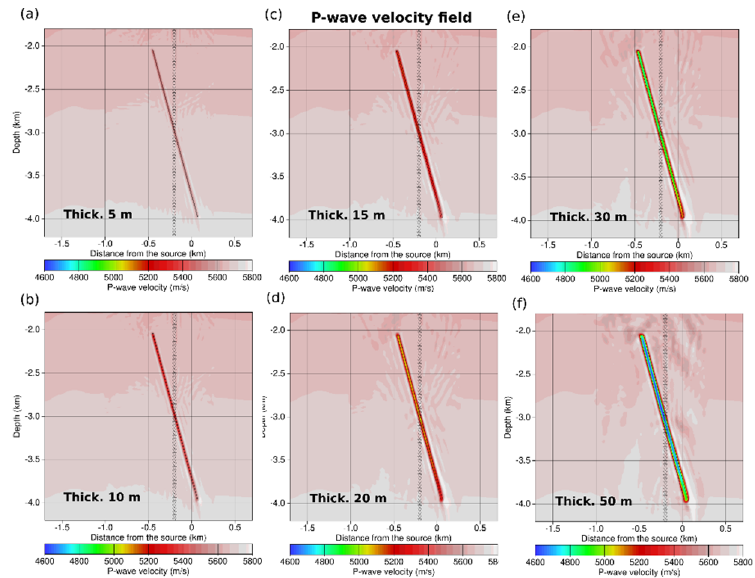
Figure 13. P-wave velocity estimated field for faults with different thicknesses: ( a ) 5 m, ( b ) 10 m, ( c ) 15 m, ( d ) 20 m, ( e ) 30 m and ( f ) 50 m. We show only the P-wave velocity in the target area limited by white block in Figure 2c. The quality results of the S-wave velocity and density are comparable to the P-wave velocity results.